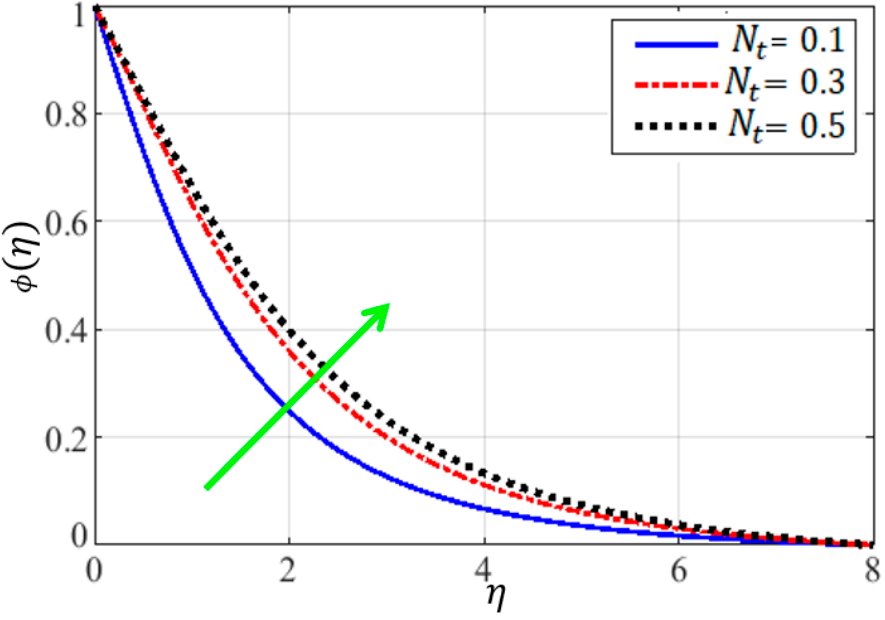
Figure 13. Impact of thermophoresis parameter on fl uid’s concentration fi eld.